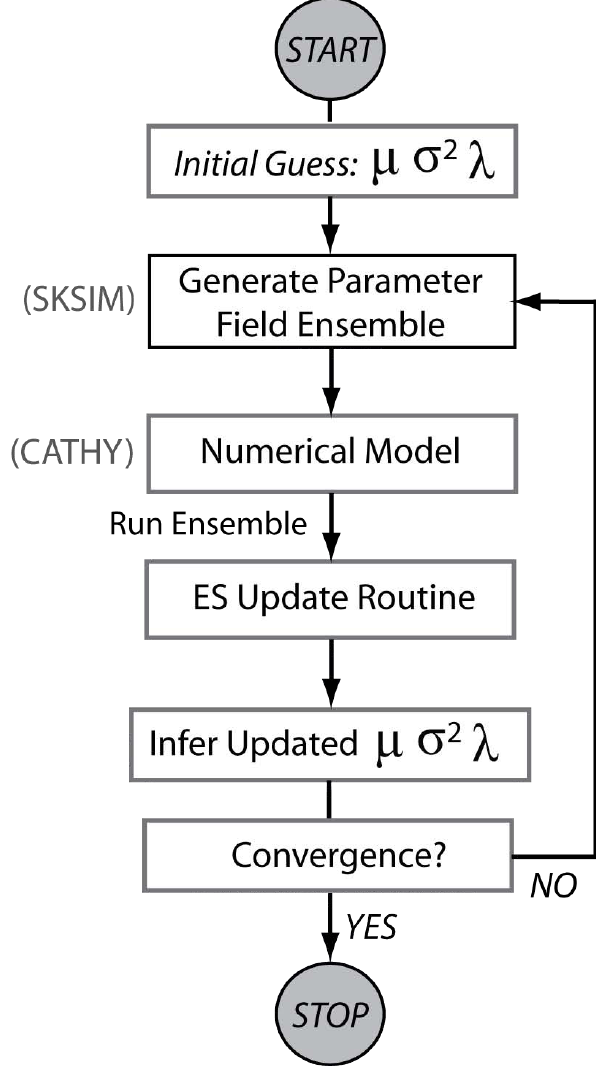
Fig. 1. Flow chart for the iterative approach using an Ensemble Smoother to estimate geostatistical